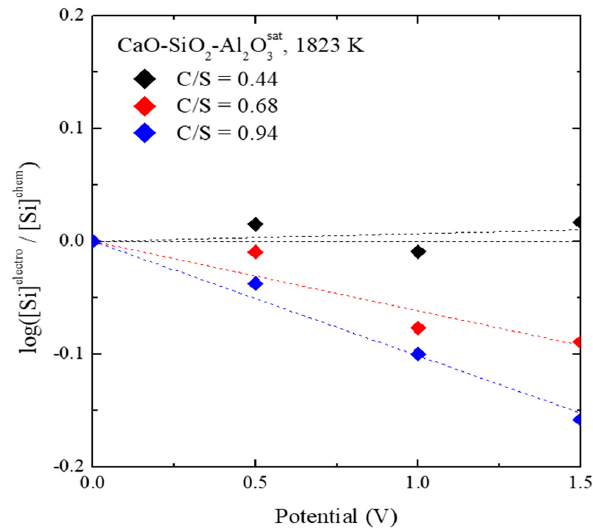
Figure 5. Silicon concentration in metal during anodic electro-desulfurization as a function of the anodic potential.